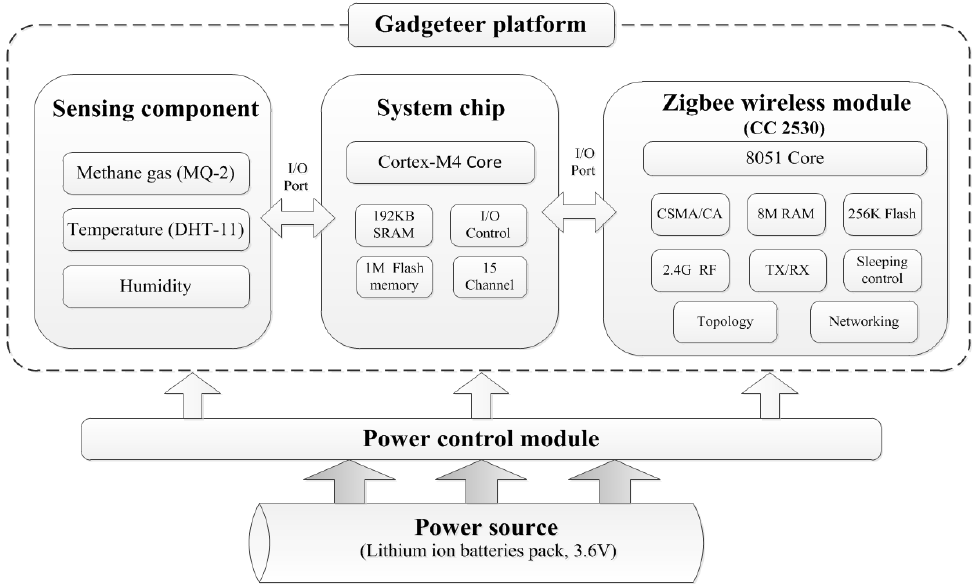
Figure 5 . The hardware framework of sensor node.